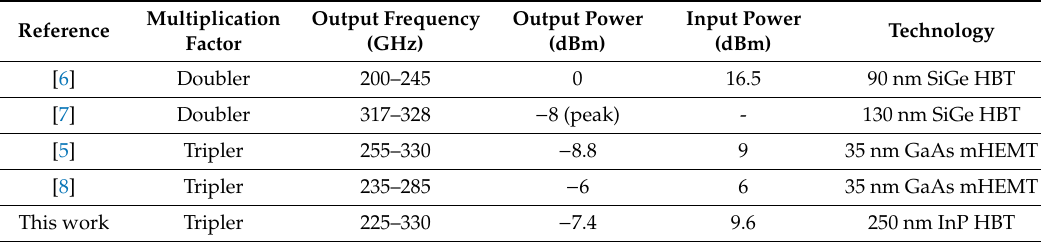
Figure 7. Measured output power at the output frequency of 273 GHz. ( a ) Output power versus input power; ( b ) output spectrum (after frequency down-conversion, using a harmonic mixer). Table 1. Comparison of active frequency multipliers reported in H -band.